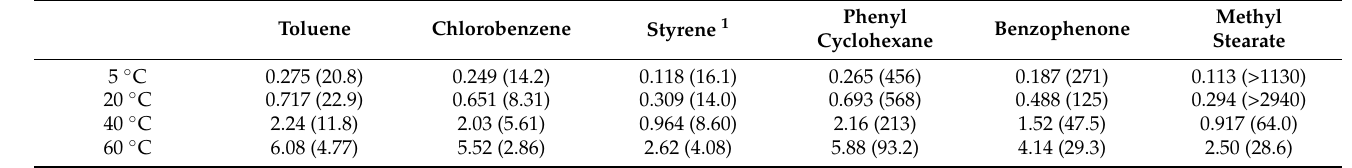
Table 3. Predicted migrated amount of surrogates from HIPS with the storage conditions 10 days at 5 ◦ C, 20 ◦ C, 40 ◦ C and 60 ◦ C (K = 1, density 1.04 g/cm 3 , layer thickness 300 µ m) and over-estimative factors from experimental migration kinetics (Table 1) compared to the modelling parameters for HIPS (A P ’ = 1.0 and τ = 0